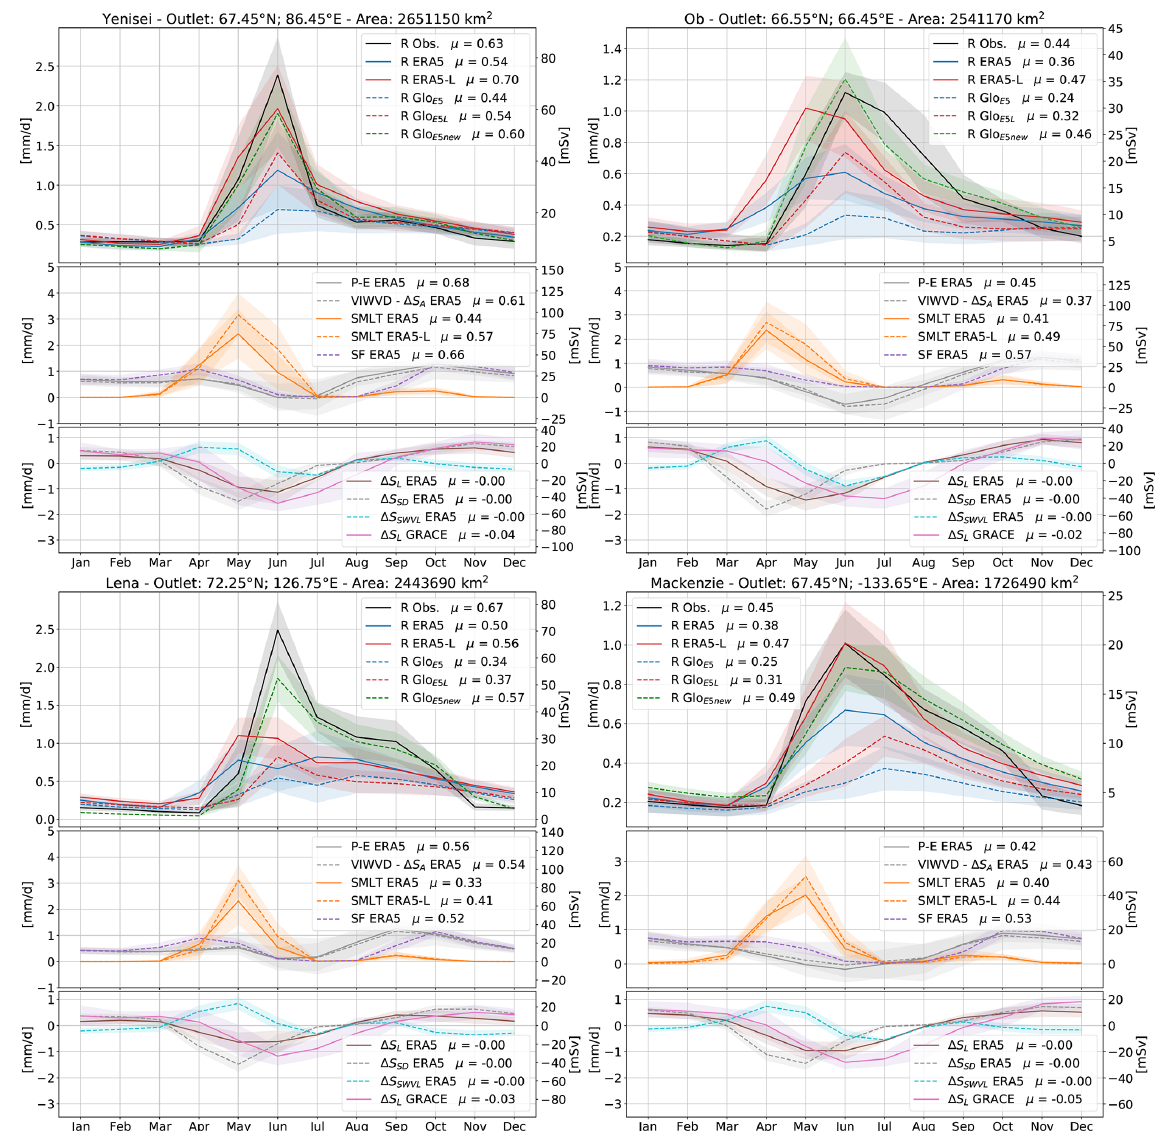
Figure 2. Yenisei, Ob, Lena, and Mackenzie seasonal cycles of runoff and river discharge ( R ) in the top panel, terrestrial net precipitation ( P − E ), divergence of moisture flux (VIWVD), snowmelt (SMLT), and snowfall (SF) in the middle and land storage change ( (cid:49)S L ), snow depth change ( (cid:49)S SD ), and soil water change ( (cid:49)S SWVL ) in the bottom panel. Seasonal cycles are calculated over the 1981–2019 period (1999–2018 for GloFAS E5L ). Shading denotes ± 1SD (1 standard deviation), and µ are the long-term means. Furthermore, geographic coordinates of gauge observations and catchment areas are given. Long-term annual means in mmd − 1 are given in the